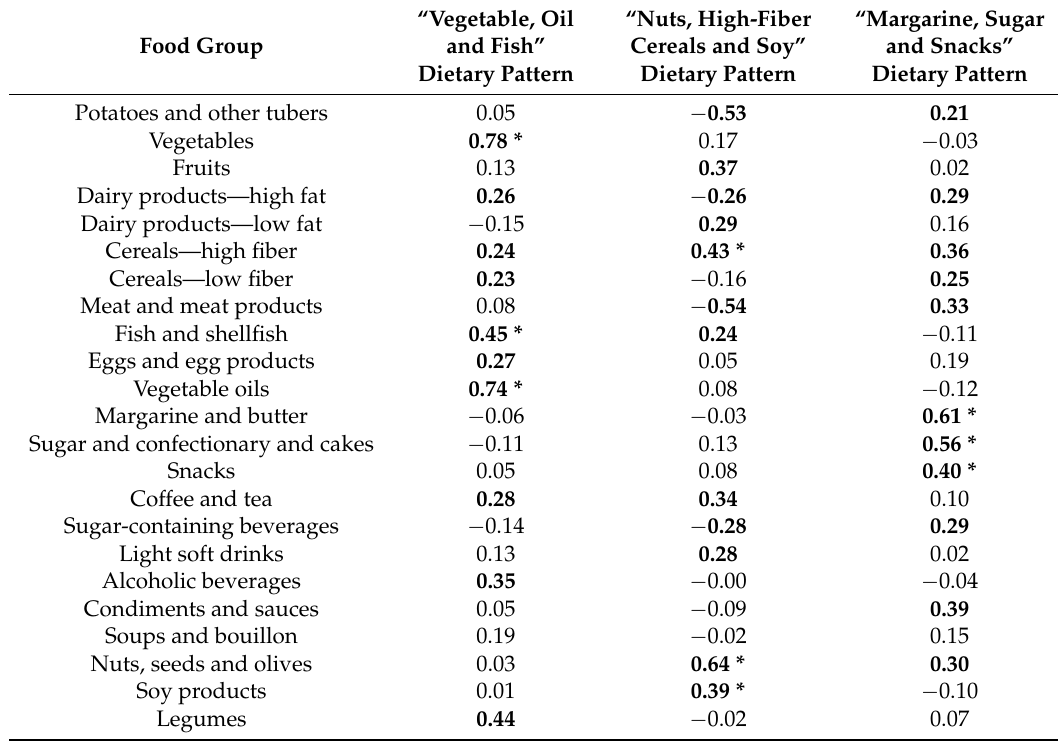
Table 1. Factor loadings food groups in a posteriori -derived dietary patterns 1